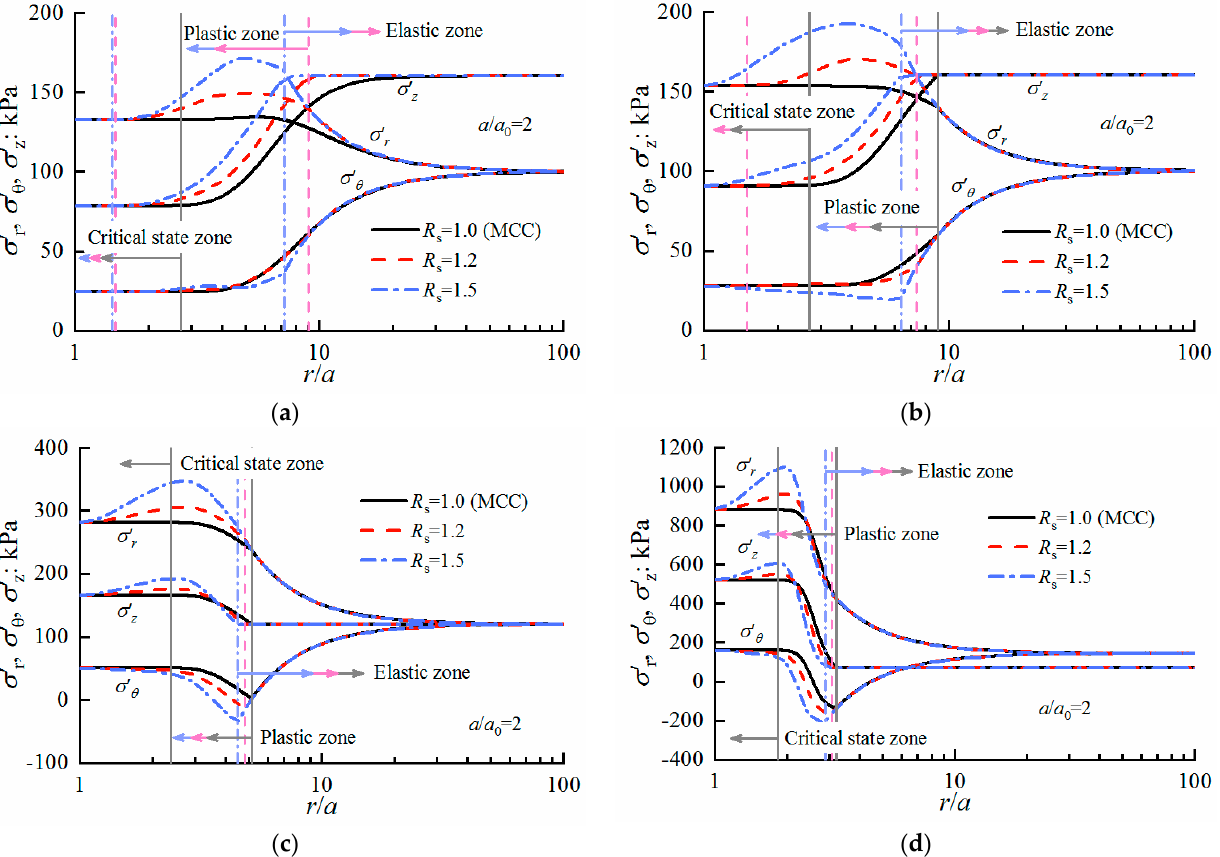
Figure 11. Influences of initial structure and destructuration on the distributions of effective stress components σ (cid:48) r , σ (cid:48) θ , and σ (cid:48) z around the cavity: ( a ) R = 1; ( b ) R = 1.2; ( c ) R = 3; ( d ) R =